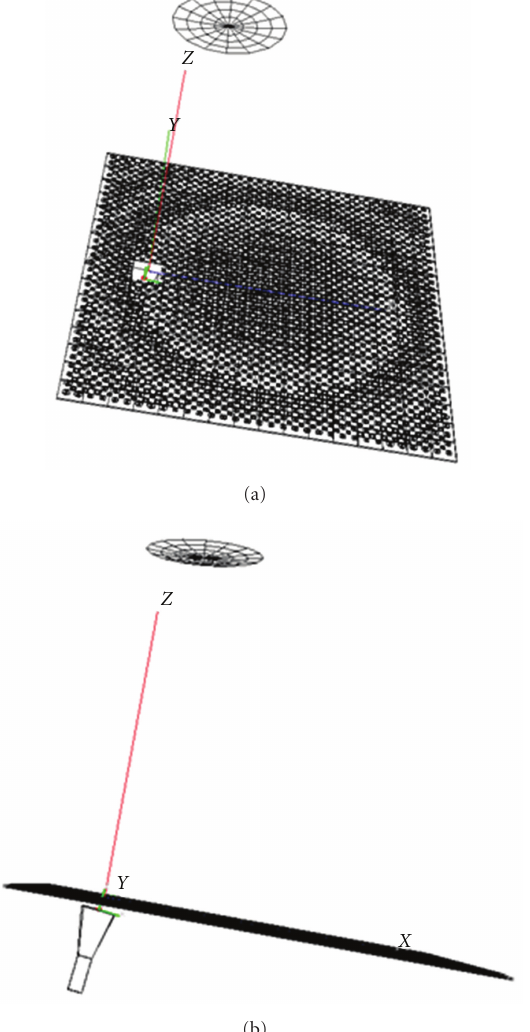
Figure 4: Geometrical views of the modified reflectarray.